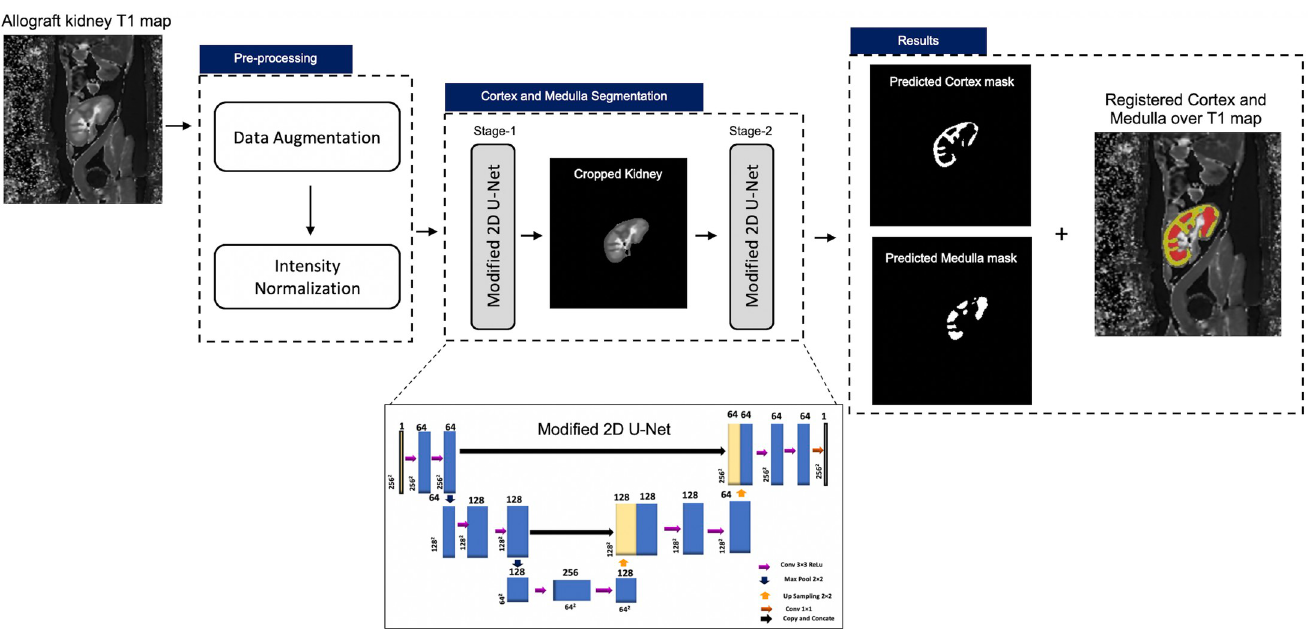
Fig 1. Schematics diagram of proposed RCM U-Net to segment the cortex and medulla of transplanted kidneys.